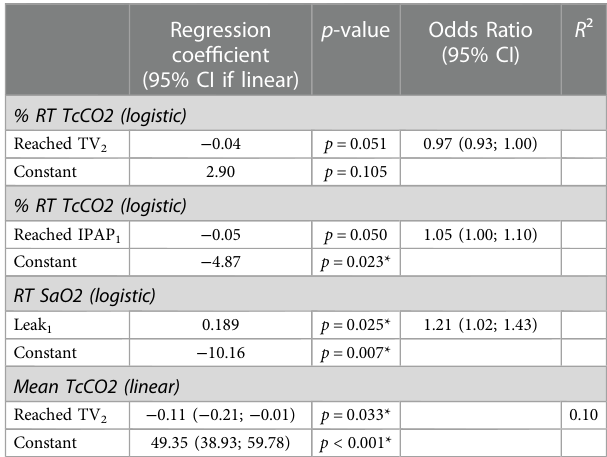
TABLE 2 Logistic and linear regression analysis for %RT TcCO2, RT SpO2 and mean TcCO2 by BIS